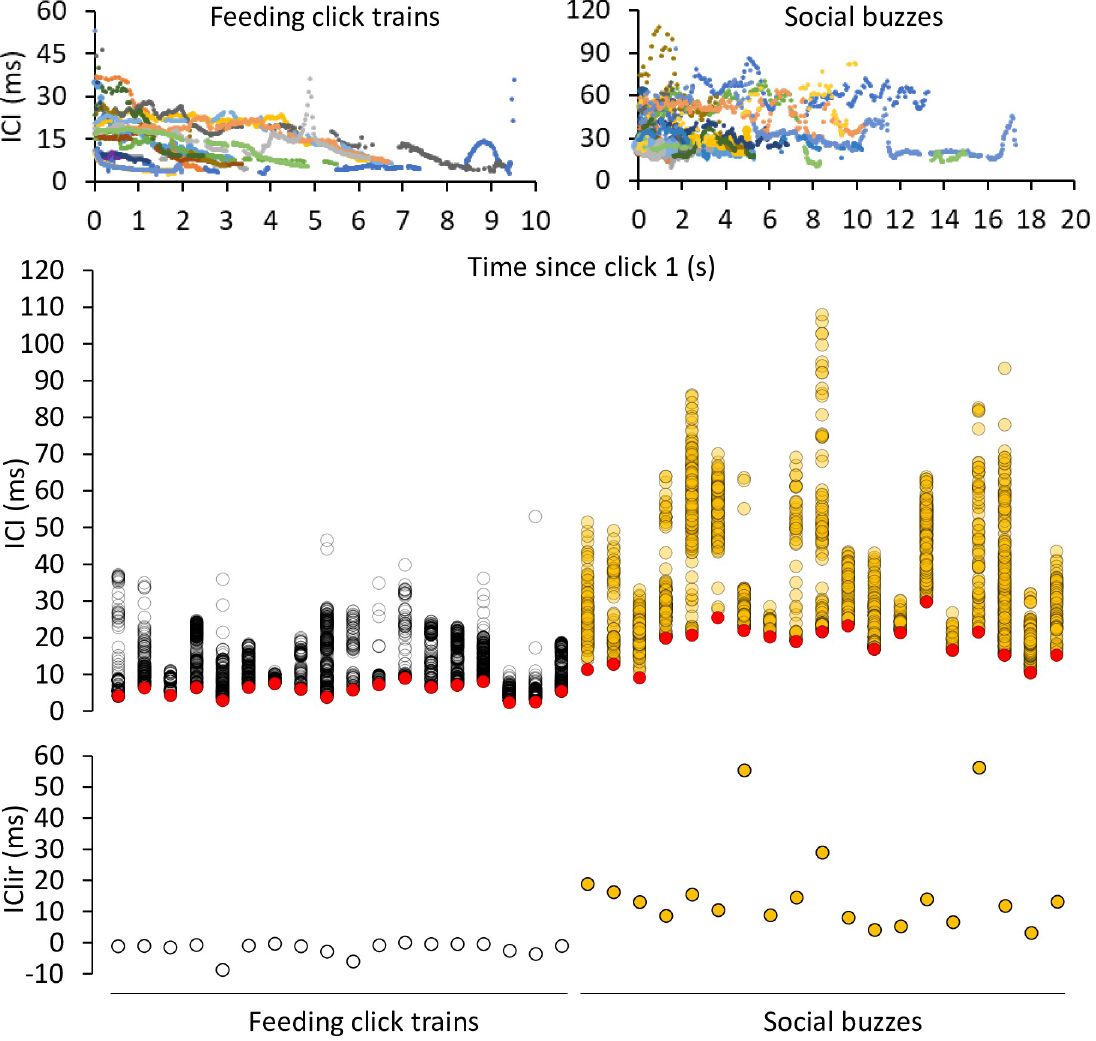
Fig 5. Upper panels—Inter-click interval (ICI) versus click time (starting at click 1 for each series) for feeding click trains (left, n = 18) and social buzzes (right, n = 19). Note Y- and X-axes differ between panels. Middle panel—Scatterplot showing the distribution of ICI (ms) per click train and their minICI (ms) in red, emitted during feeding behavior and social interaction. Lower panel—Scatterplot showing the distribution of ICIir (ms) per click train, emitted during feeding behavior and social interaction.